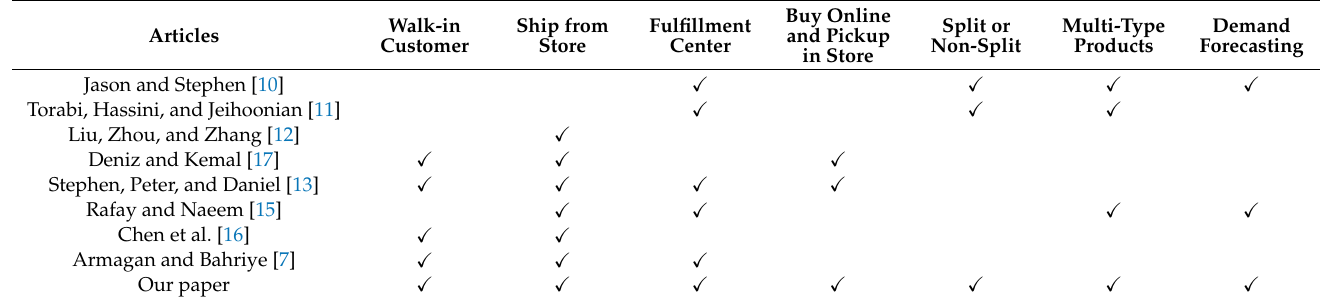
Table 2. Comparison of our paper with related